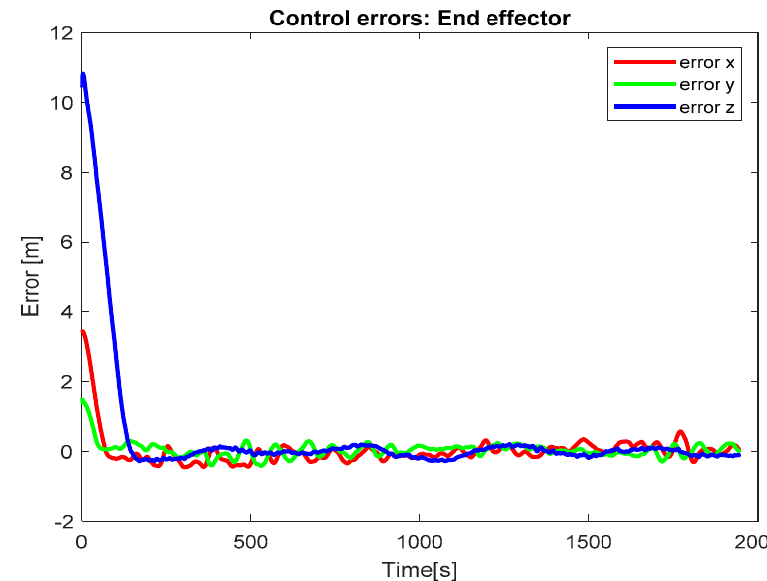
Figure 15. Control errors: LAMDA controller.